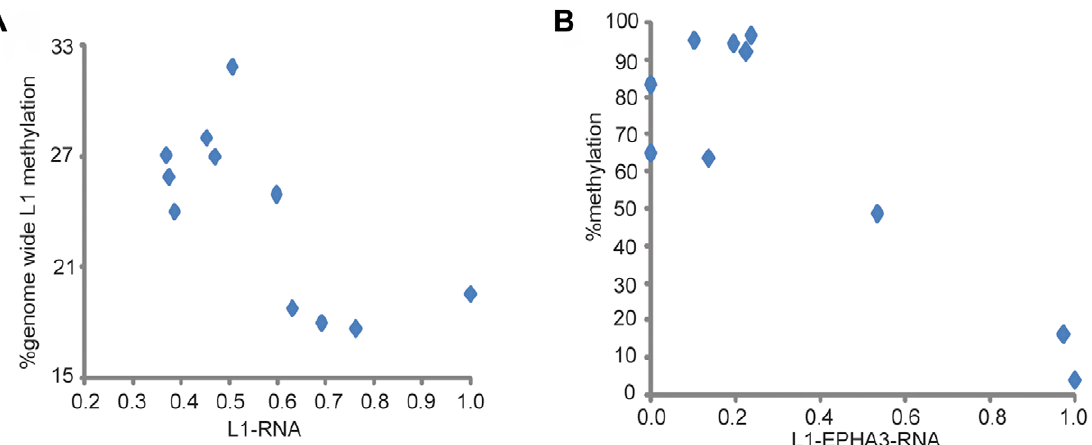
Figure 4. L1 hypomethylation increases L1 RNA. A) Genome wide L1 methylation and L1 RNA levels in WSU-HN cells. B) L1-EPHA3 methylation and L1-EPHA3 RNA levels.